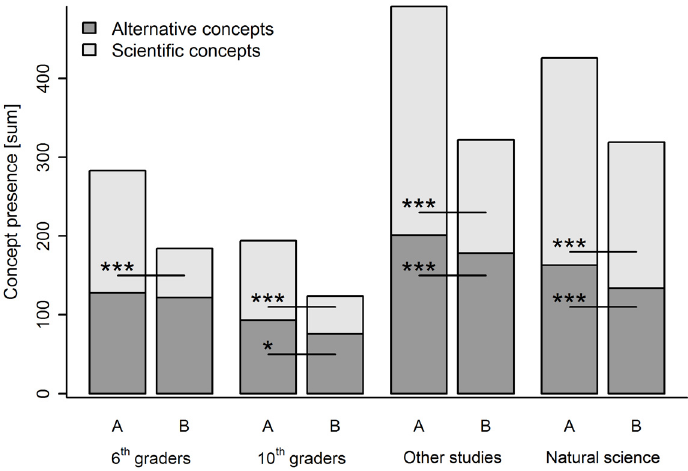
Fig 2. Presence of scientific and alternative conceptions divided by questions and educational backgrounds (N = 885, based on GLM, concepts as command variable with educational background, sex and age as random factor, for multiple comparison adjusted significance levels are marked by * < 0.05, ** < 0.01, *** < 0.001 above lines, for exact p-values see S4